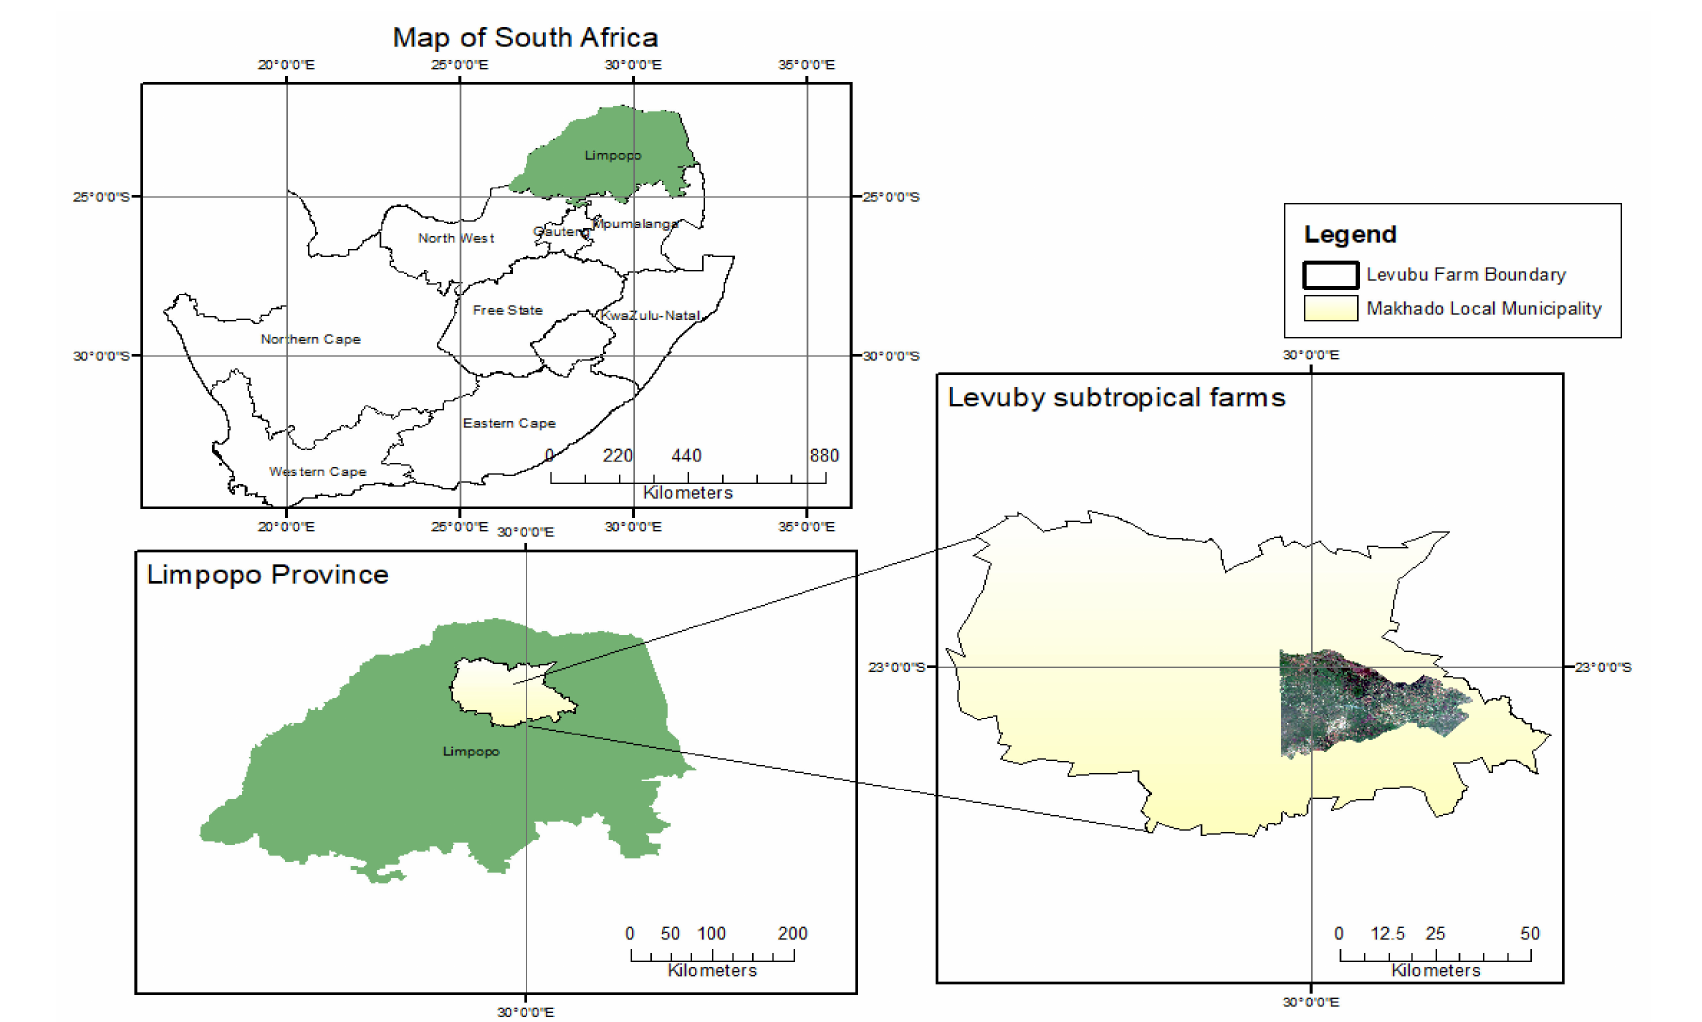
Figure 2. Map of South African provinces showing the location of Levubu sub-tropical farming area in Sentinel-2 RGB image located in Makhado Local